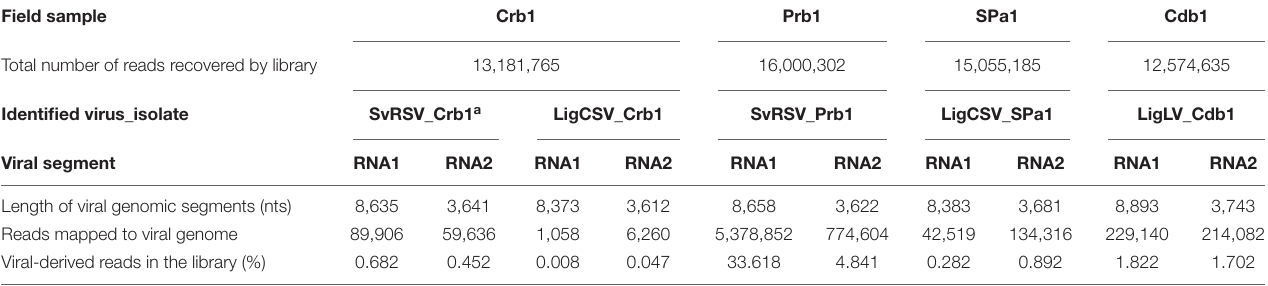
TABLE 2 | Description of high-throughput sequencing libraries obtained in this